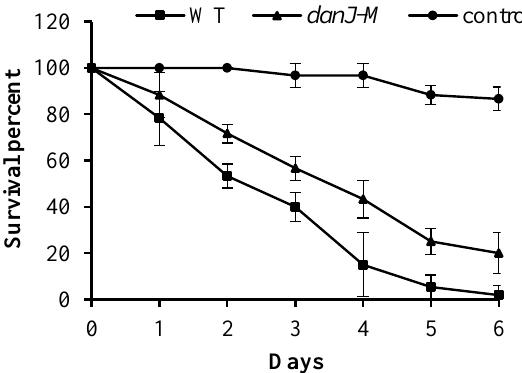
Figure 4. Analysis of P. aeruginosa pathogenicity using the Drosophila melanogaster infection model. Survival curves of the fruit flies chronically infected with different strains are shown. Square: flies infected with the wild type; Triangles: flies infected with the dnaJ-M ; Circles: uninfected controls.